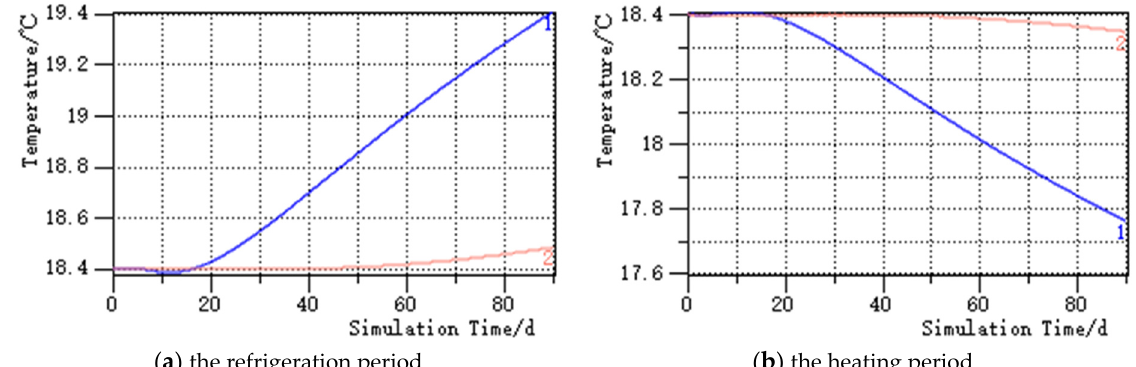
Figure 6. Temporal temperature variation processes of the observation points under the operation of a single BHE.